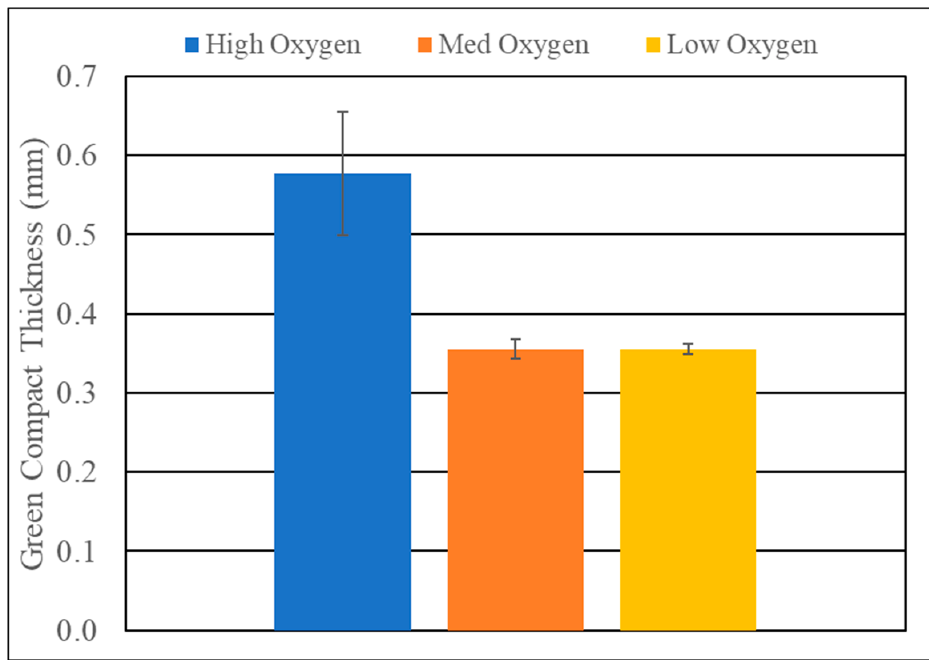
Figure 18. Percent mass compaction data of impacted green bodies for evaluated AL6061 powders.